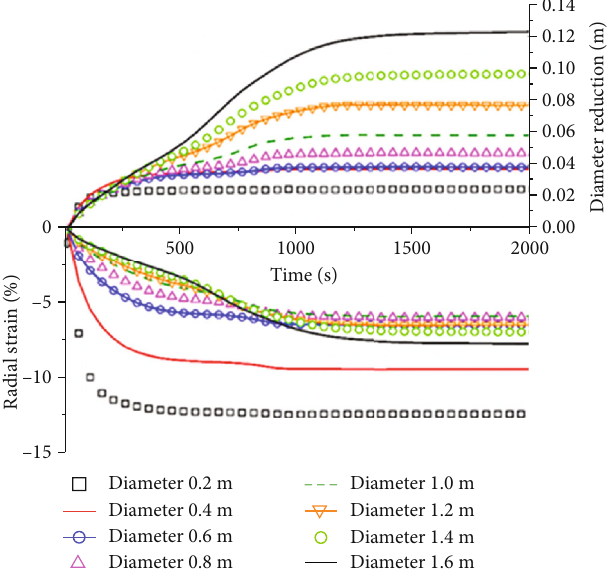
Figure 13: Relationships between radial strain, diameter reduction, and time under di ff erent initial borehole diameters (depth 400 mbsf).